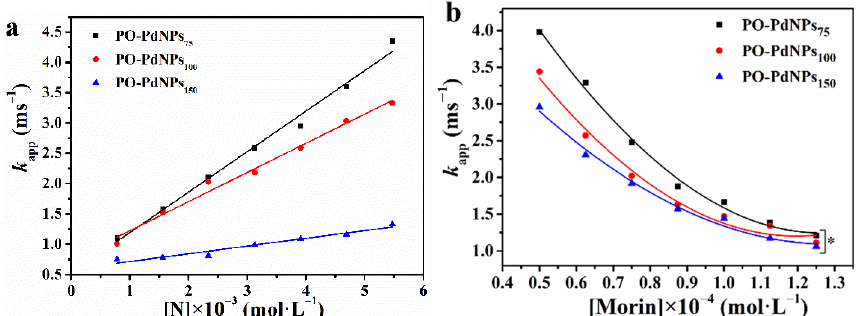
Figure 8. ( a ) The effect of different concentration and ratio of catalysts on the catalytic reaction k app . ( b ) The effect of different concentrations of morin on the catalytic reaction k app (C H2O2 = 10 mM, C [N] = 0.78 mM). * p <